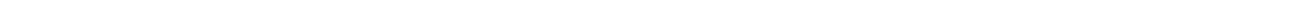
Figure 5 | Palmitoylation-deficient Fas prevents autoantibody production. ( a ) Spleens from 30 week-old WT, lpr/ þ , lpr/lpr and FasC194V lpr/lpr mice were isolated and stained for surface IgM and IgD expression in B cells. All cells are gated TCR b (cid:2) CD19 þ B220 þ in the viable cell pool. Results are representative of six independent experiments ( N ¼ 6). ( b ) Fresh splenocytes from the indicated genotypes were stained for CD38 and GL-7. All cells